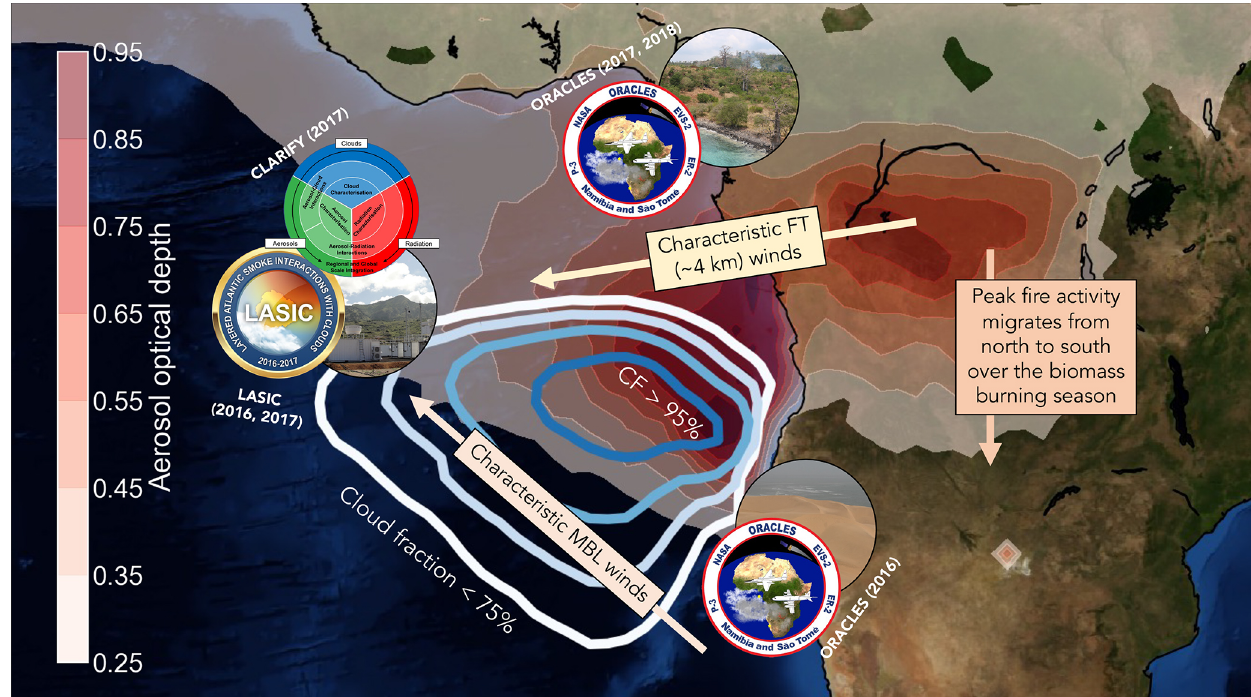
Figure 1. Overview of the SEA smoke–cloud–climate system and recent campaigns. Smoke (shading, as represented by aerosol optical depth from the Moderate-Resolution Imaging Spectroradiometer on Aqua) and cloud fraction (contours, from the Clouds and the Earth’s Radiant Energy System Energy Balanced and Filled product) are averaged over the southern African biomass burning season (June–October) from 2003 to 2015. Logos and local images indicate the ORACLES deployment sites in Namibia (2016) and São Tomé (2017–2018). A logo for the CLARIFY campaign and the logo and image from the LASIC deployment are placed near Ascension Island. Characteristic MBL winds, FT winds (at ∼ 4km), and seasonal fire migration are represented by schematic arrows. The background image is from the NASA Visible Earth Blue Marble